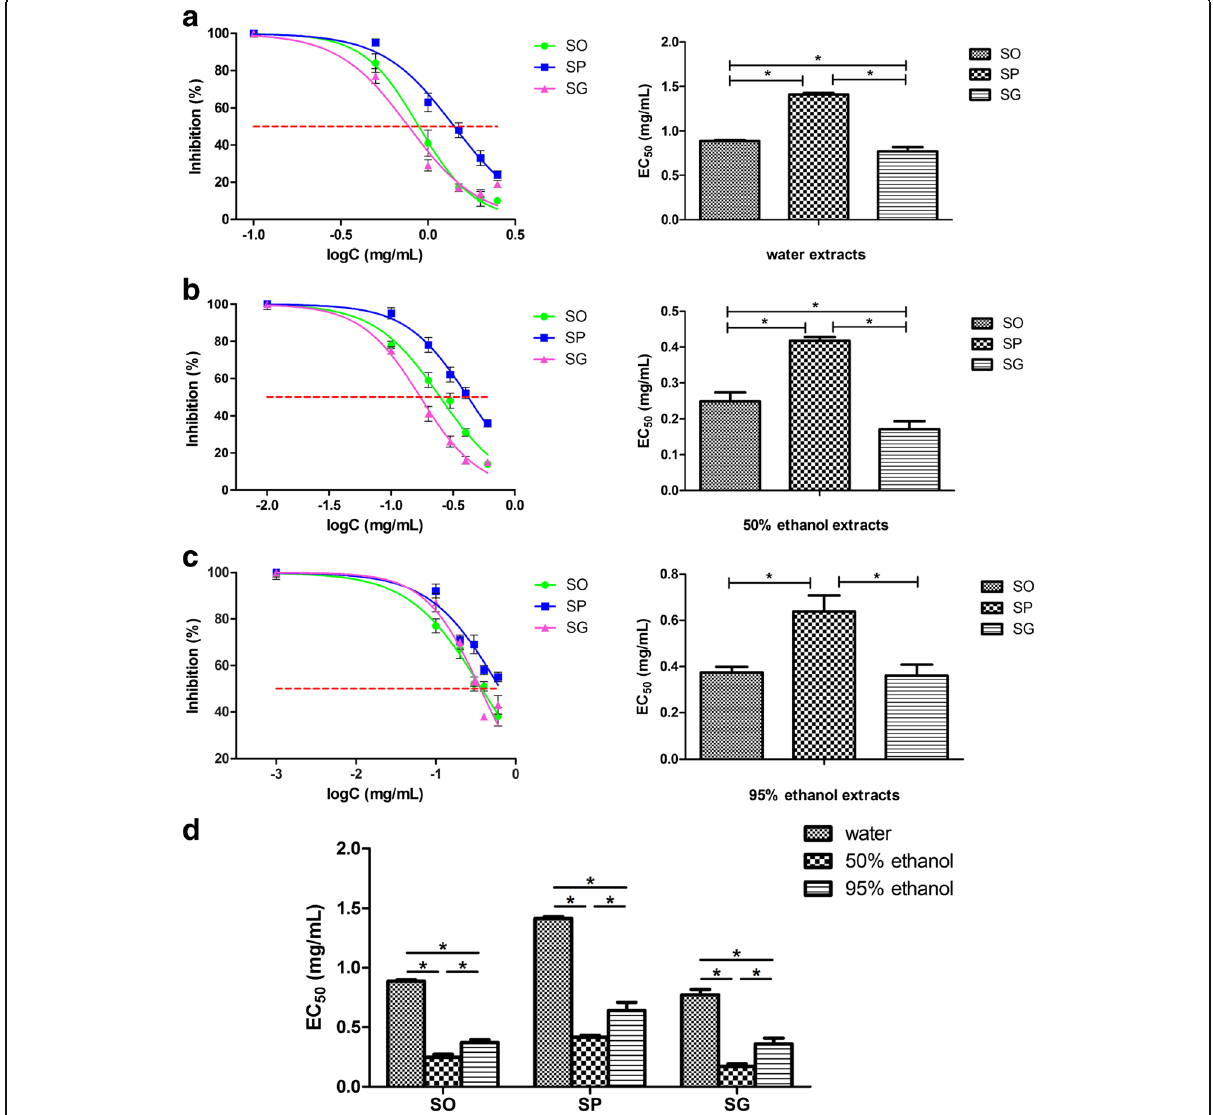
Fig. 4 Bioactivity comparison results of SO, SP and SG. a Effects of water extracts on NO production. b Effects of 50% ethanol extracts on NO production. c Effects of 95% ethanol extracts on NO production. RAW 264.7 cells were treated with various concentrations of individual extract for 1 h and then stimulated with 100 ng/mL LPS for 24 h. NO production was indicated by the level of nitrite in the supernatant measured with the Griess reagent. Inhibition rate (%) of an extract was calculated against LPS alone-treated cells. EC 50 was calculated using the curve-fitting software GraphPad Prism 5.0. d Summary of EC 50 values shown in ( a ), ( b ) and ( c ). Data are shown as mean ± SD from tree independent experiments. # p < 0.05, * p <